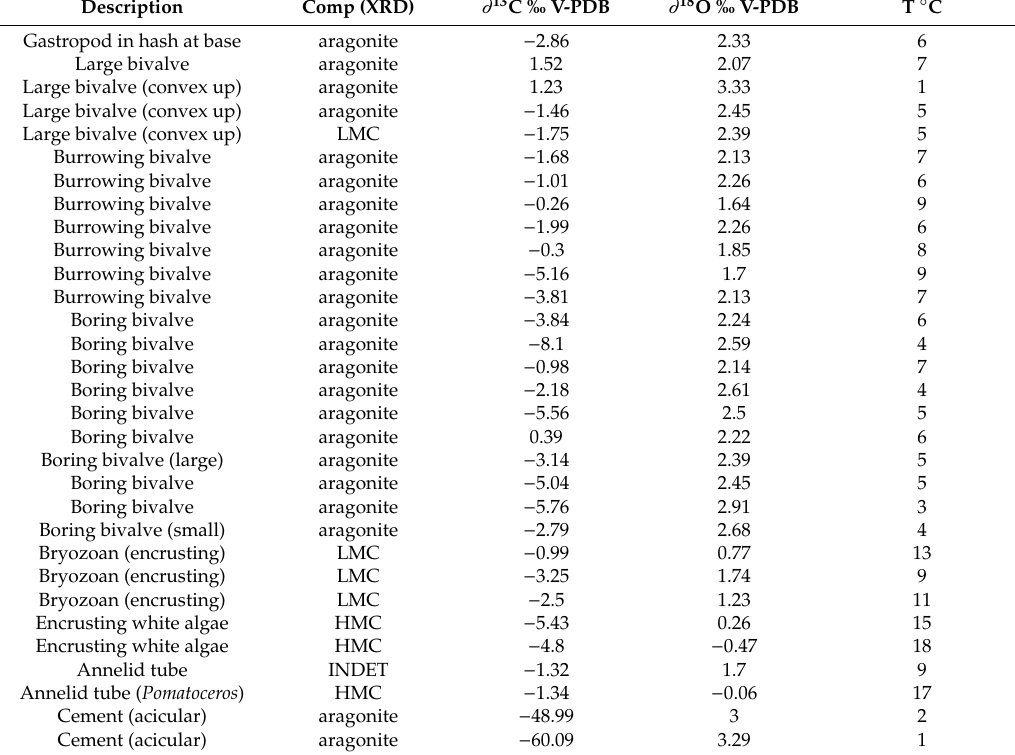
Table 1. Composition (X-ray di ff raction (XRD)), ∂ 13 C ‰ V-PDB, ∂ 18 O ‰ V-PDB and temperature, for biological calcite and aragonite cement from the Rathlin sample. Analytical precision ±